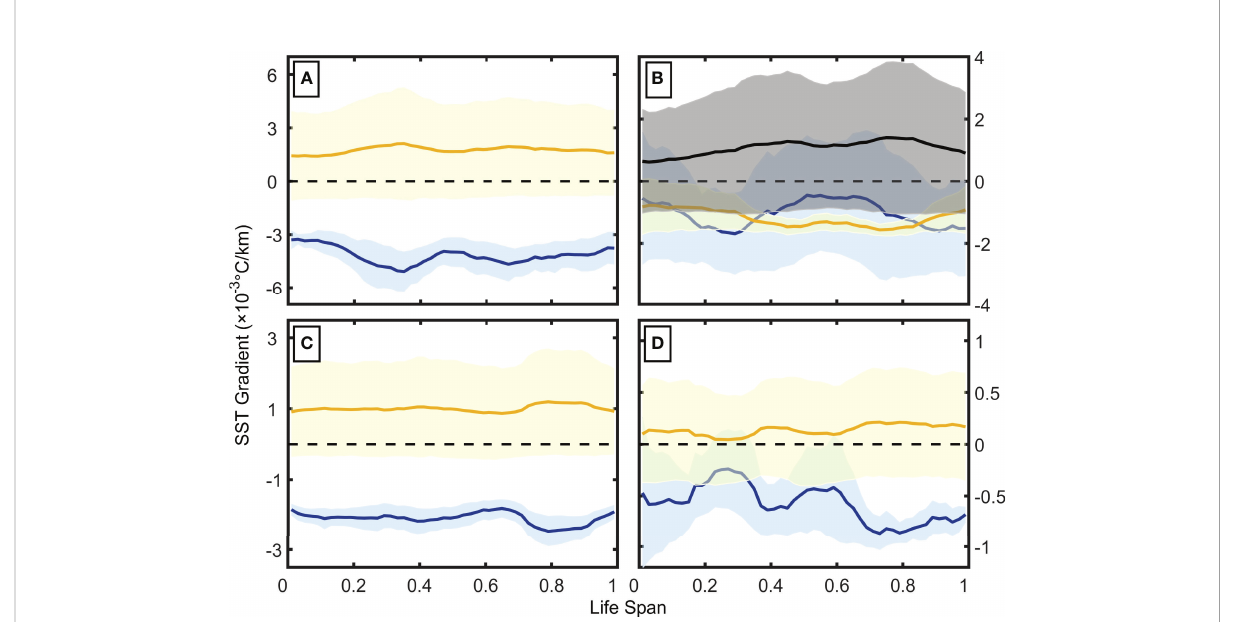
FIGURE 7 Temporal evolutions of the averaged SST gradient (×10 -3 °C/km) inside (blue) and outside (yellow) (A) anticyclonic and (B) cyclonic eddies in the north (the black line is the averaged SST gradient over the middle area of cyclonic eddies in the north) and (C) anticyclonic and (D) cyclonic eddies in the south. The gray, blue and yellow shading represents the standard